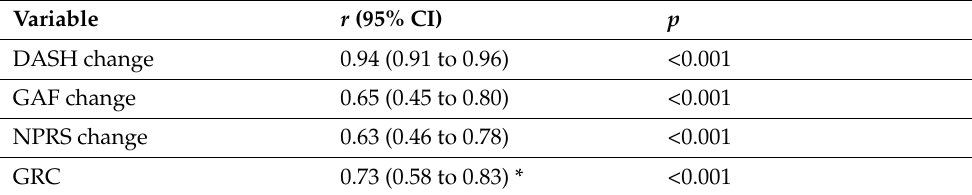
Figure 1. Histogram showing the Arabic UEFI change scores distribution ( N = 63). Table 4. Correlation between the Arabic UEFI change score and other measures (N = 63).